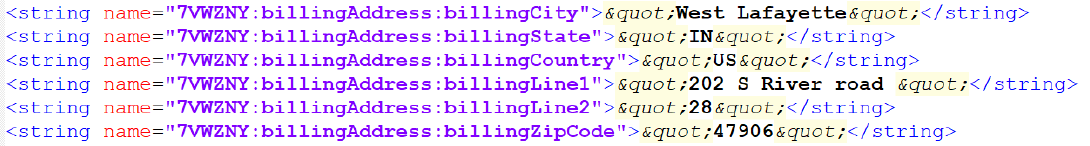
Figure 6. Full billing address stored as XML data was found in a file. The relevant XML data was extracted from the original file to omit irrelevant data.